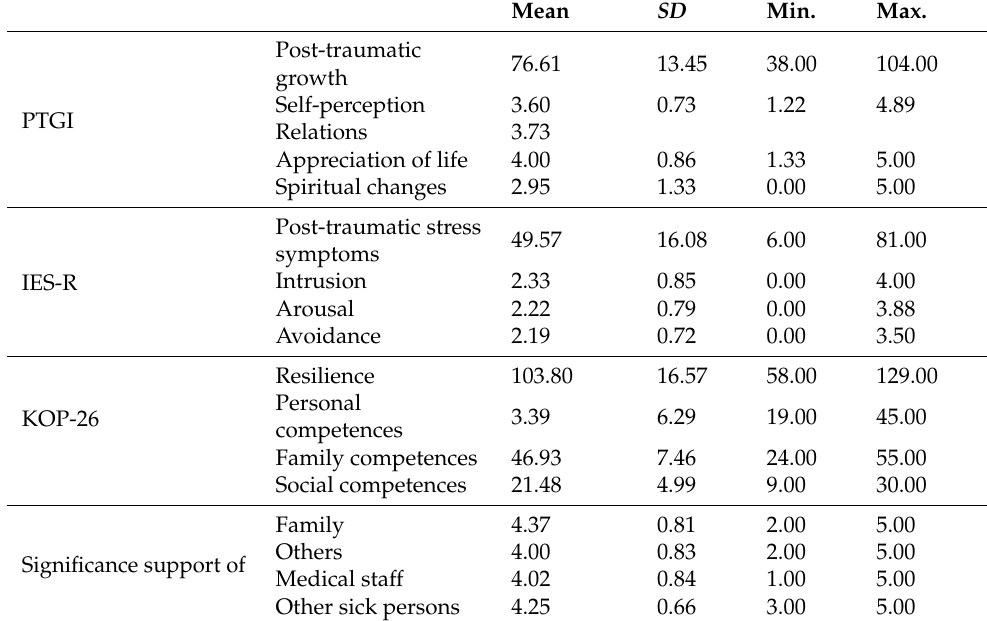
Table 2. Descriptive statistics of quantitative variables.